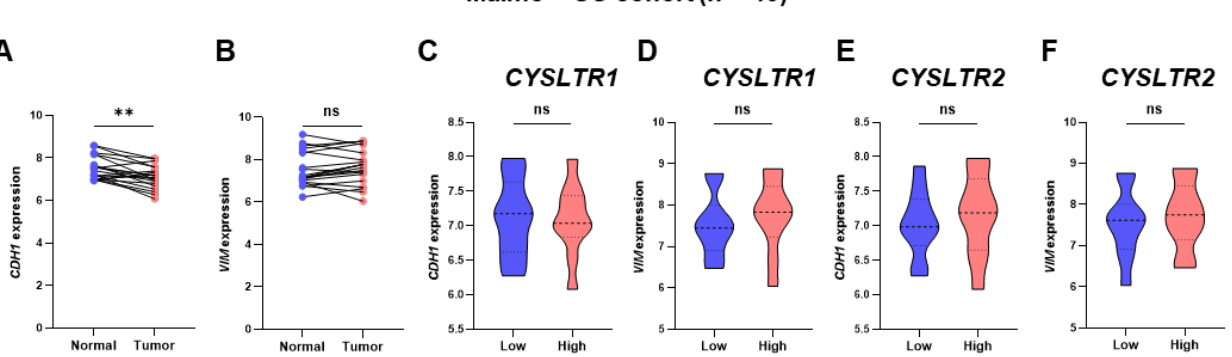
Figure 7. Expression of the EMT markers CDH1 and VIM in patient samples with low and high expression of CYSLTR1 and CYSLTR2 genes in the Malmö–CC clinical cohort. Relative expression of CDH1 ( A ) and VIM ( B ) genes between normal and primary tumor samples. CDH1 ( C ) and VIM ( D ) gene expressions in low and high CYSLTR1 groups of patients. CDH1 ( E ) and VIM ( F ) gene expressions in low and high CYSLTR2 group of patients. ** p < 0.01; ns = non-significant .